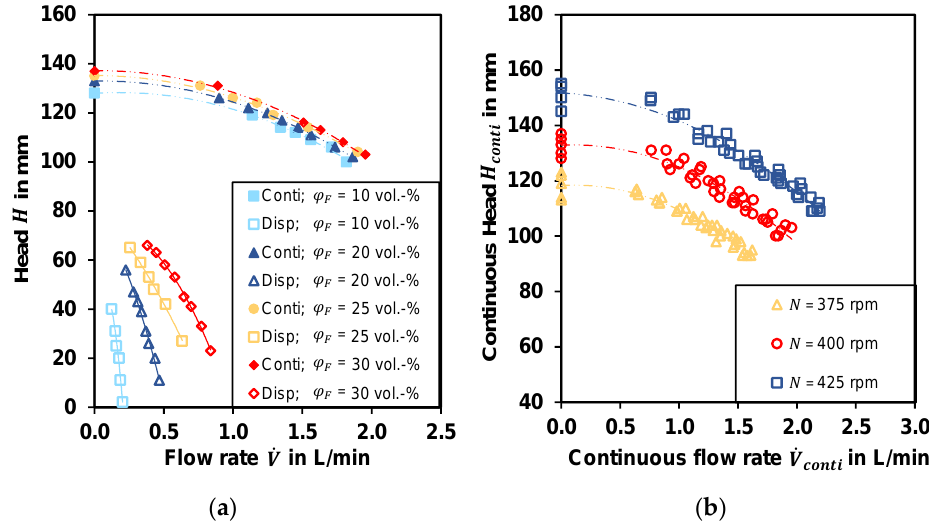
Figure 5. ( a ) Measured heads and flow rates for 𝑁 = 400 rpm. ( b ) Measured heads and flow rates of the continuous phase for 𝑁 = 375, 400, and 425 rpm for all measured feed phase ratios. The lines are the pumping curves calculated as quadratic polynomials as a guide for the eye.